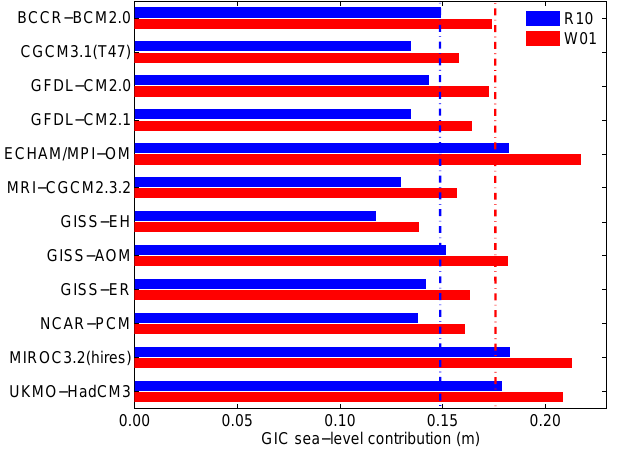
Fig. 11. GIC sea-level contribution (m) for the 12 climate models and the two glacier inventories (1990-2090). Dashed lines represent model mean contribution for each